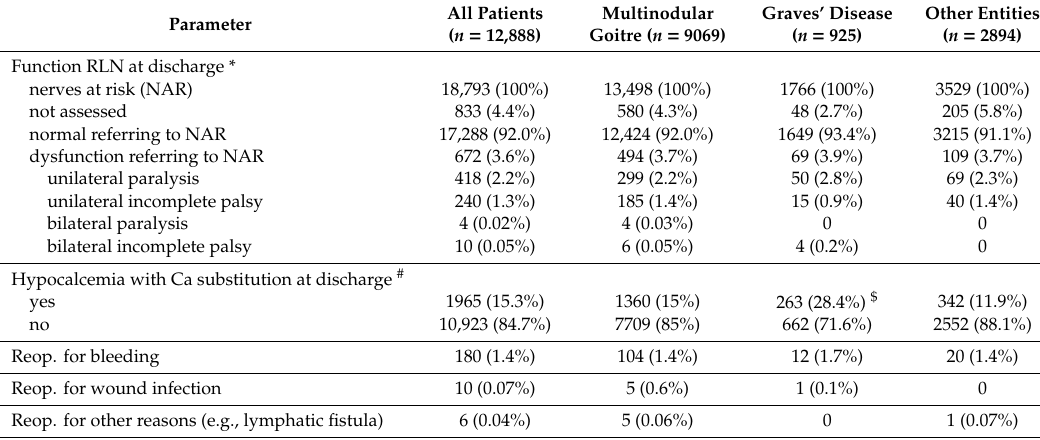
Table 5. Postoperative